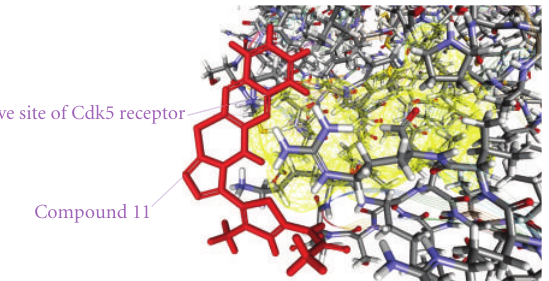
Figure 11: The docked conformation of compound 11 with the receptor CDK5/p25 (PDB: 3O0G). Compound 11 is indicated by red color while the most active site of the CDK5 receptor is shown with yellow color.